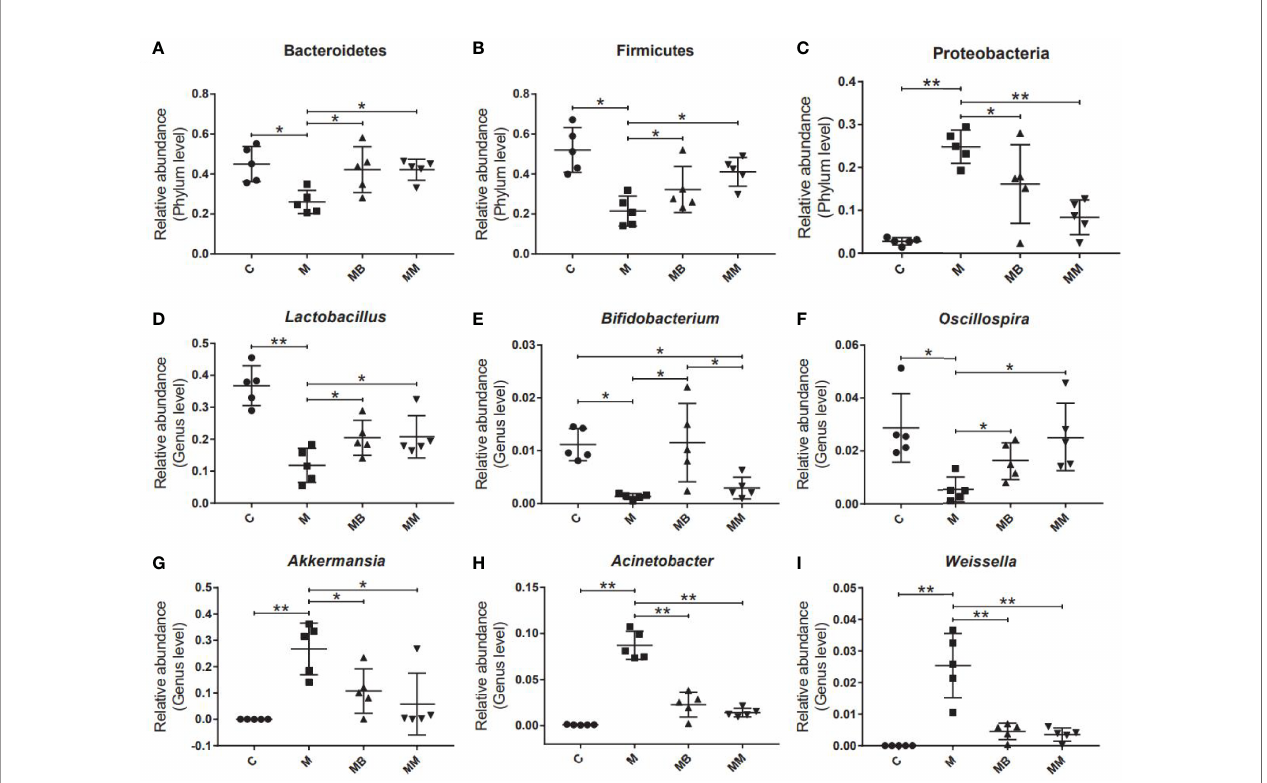
FIGURE 4 | BefA protein regulated blood sugar by increasing the abundance of intestinal bene fi cial bacteria. The relative abundance of Bacteroides (A) , Firmicutes (B) , Proteobacteria (C) , Lactobacillus (D) , Bi fi dobacterium (E) , Oscillospria (F) , Akkermansia (G) , Acinetobacter (H) and Weissella (I) were analyzed. Data are presented as means ± SD. One way repeated-measures ANOVA with Tukey ’ s test for multiple comparisons ( A – I , respectively); * p < 0.05, ** p <